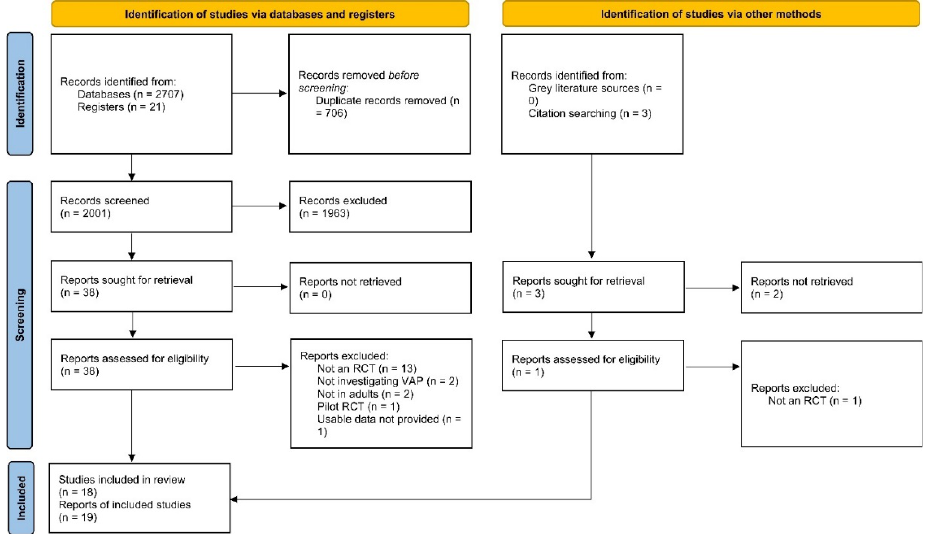
Figure 1. PRISMA 2020 flow chart. Flow chart of included and excluded trials. PRISMA, Preferred Reporting Items for Systematic Reviews and Meta-Analyses.